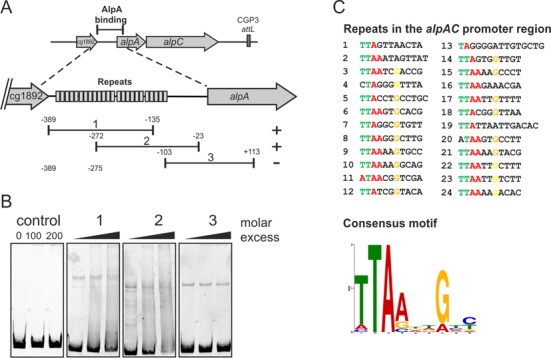
AlpA binds to conserved repeats in the alpAC promoter region. (A) Overview of the tested sub-fragments covering the upstream promoter region of alpAC. The conserved repeats are indicated as boxes. (B) Corresponding EMSA study to (A). To test for AlpA–DNA interaction, the DNA fragments were incubated with varying molar excess of AlpA (0-, 200- and 500-fold molar excess of AlpA; see supplemental material). (C) Conserved repeats in the alpAC promoter region. A consensus motif was derived using the MEME suite software (http://meme.nbcr.net/meme/).